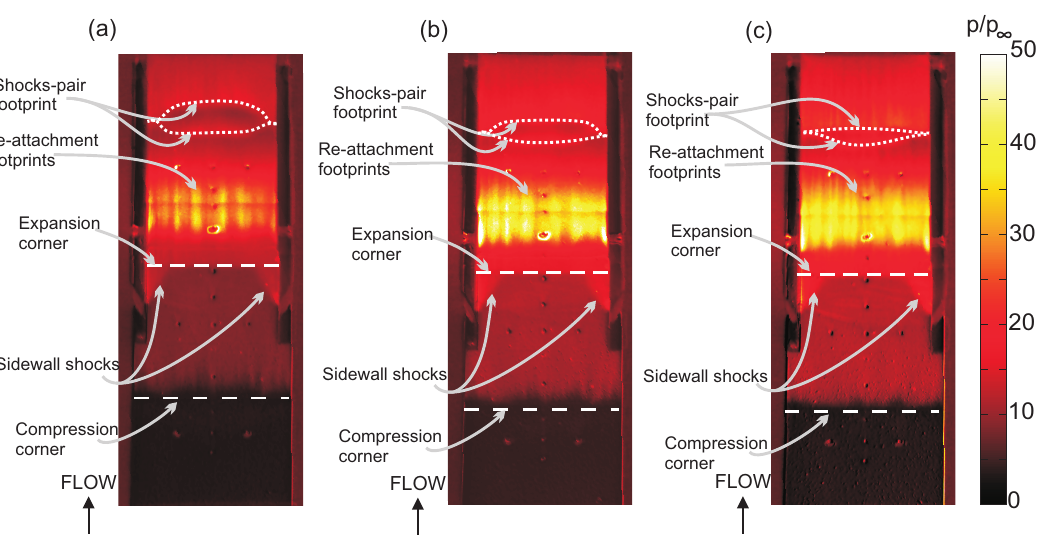
Figure 14. Normalized static pressure map taken from the top of the